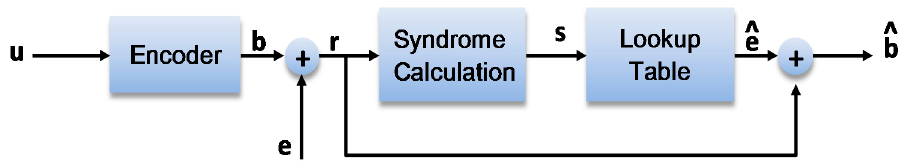
Figure 1. Encoding, channel crossing, and syndrome decoding processes.